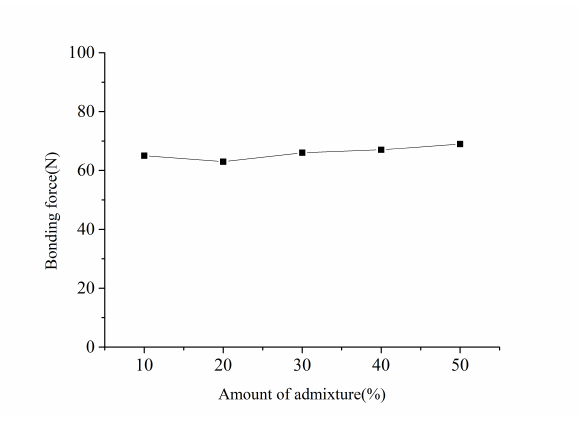
Figure 6: Bonding force versus aluminum powder content